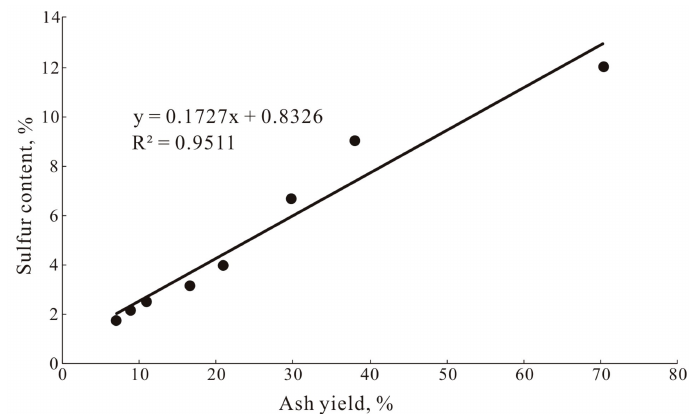
Figure 4. The relation between ash yield and sulfur content among different density fractions.